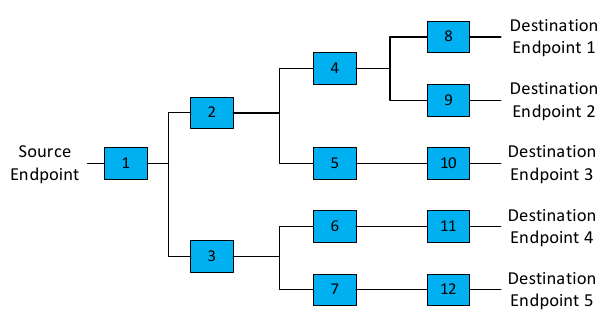
Figure 9. Un-optimized Tree Structure for a signal category Data1:N Table 1. Number of flops without optimized tree